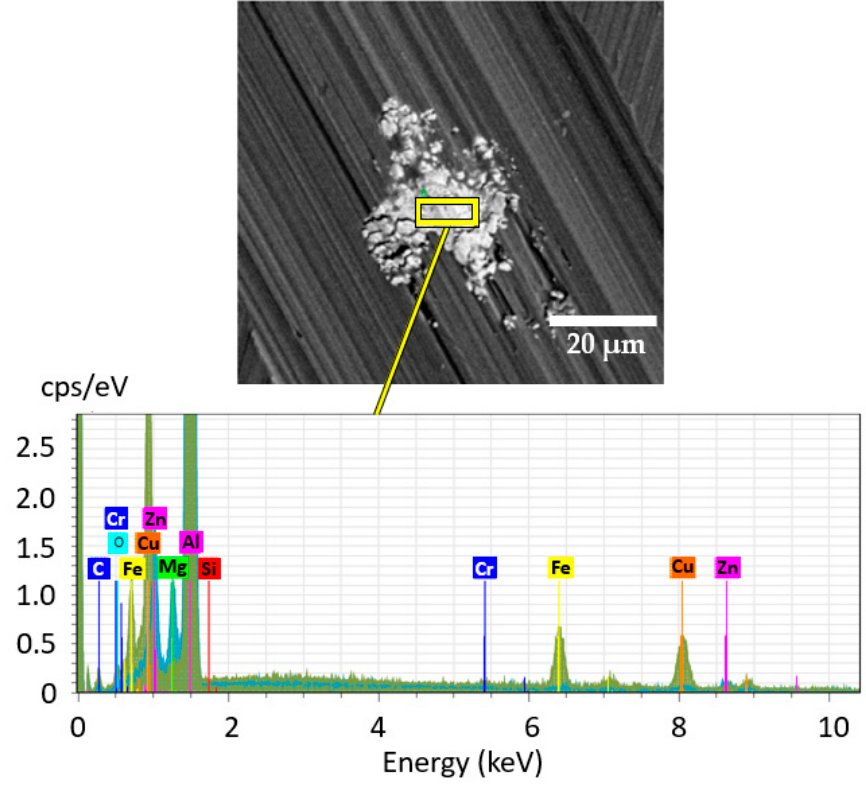
Figure 3. EDX of a selected intermetallic particle in alloy 7475-T7351.